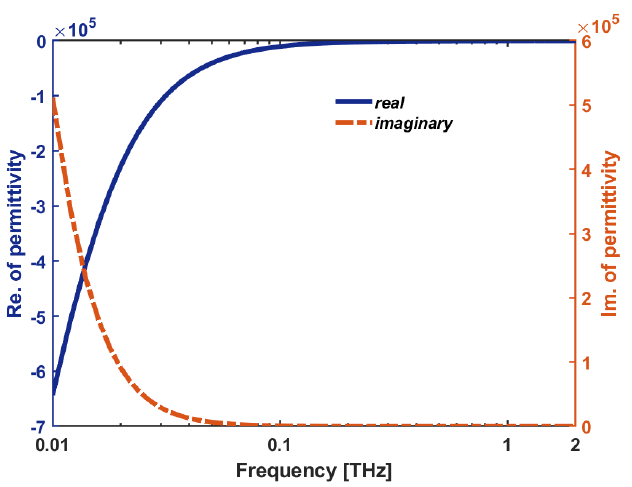
Figure 2. The complex dielectric function ( 𝜖 𝐷𝑀 (𝜔) : electric permittivity) of InSb vs frequency. Here, T is the absolute temperature and k B is the Boltzmann constant. Equation (4)